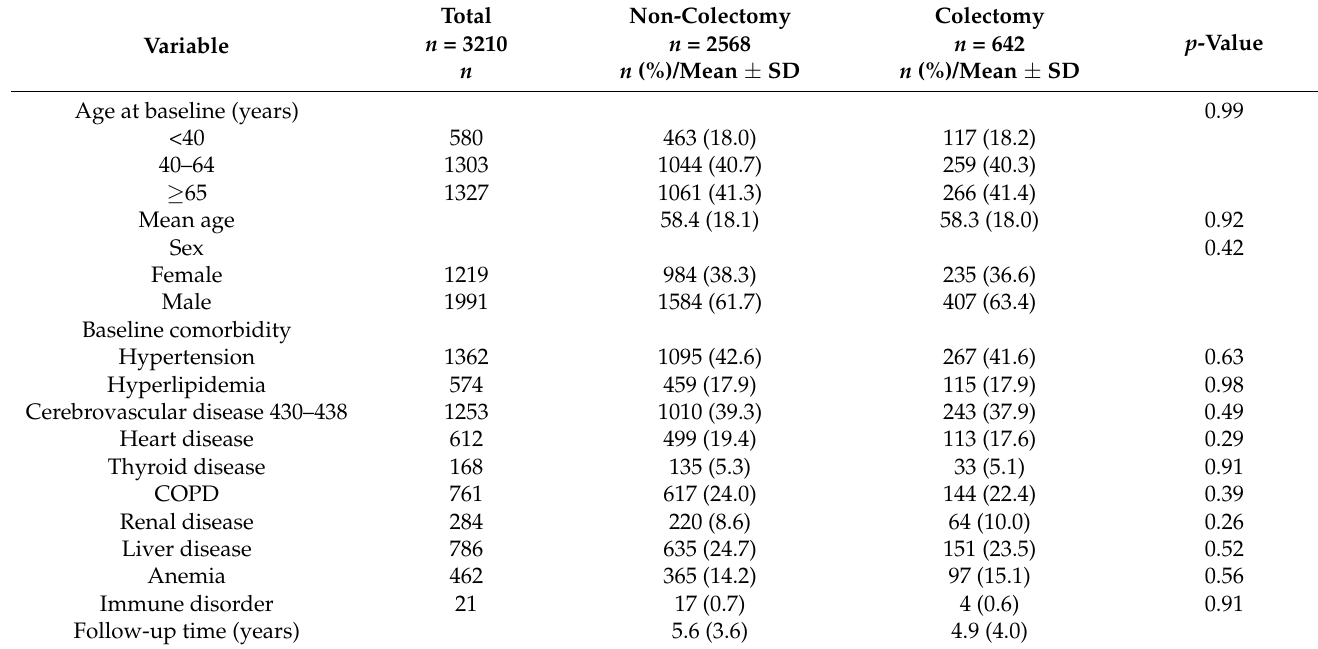
Table 1. Demographic characteristics and comorbidities of patients who underwent colectomy in Taiwan from 2000–2012.